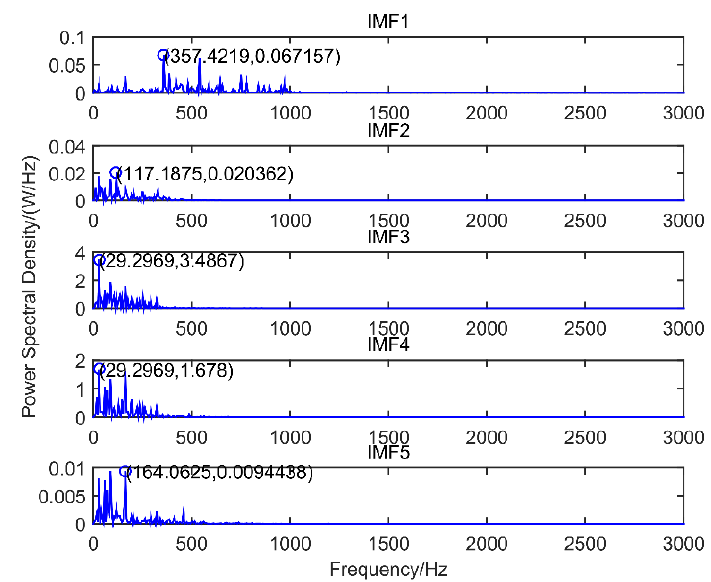
Figure 6. The power spectrum of motor bearing inner race. Table 2. Power spectrum results of two